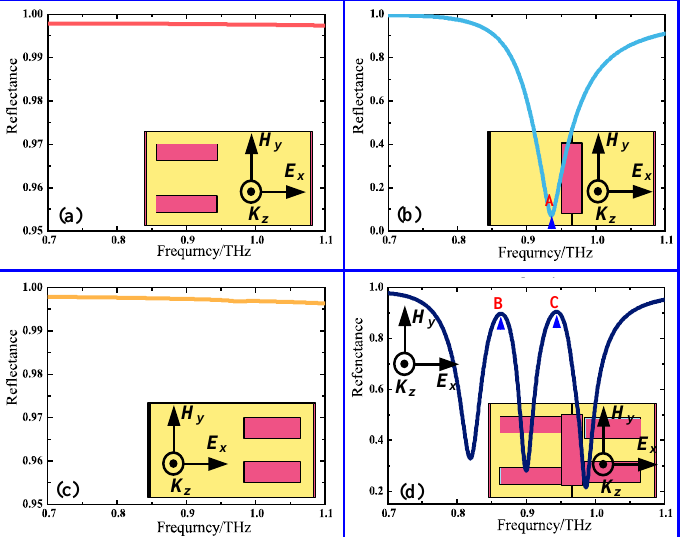
Figure 2. Reflection spectra of four different complementary MSs for x -polarized incident waves: ( a ) longer quadrupole slot array alone, ( b ) dipole slot array alone, ( c ) shorter quadrupole slot array alone, and ( d ) their combined structure.